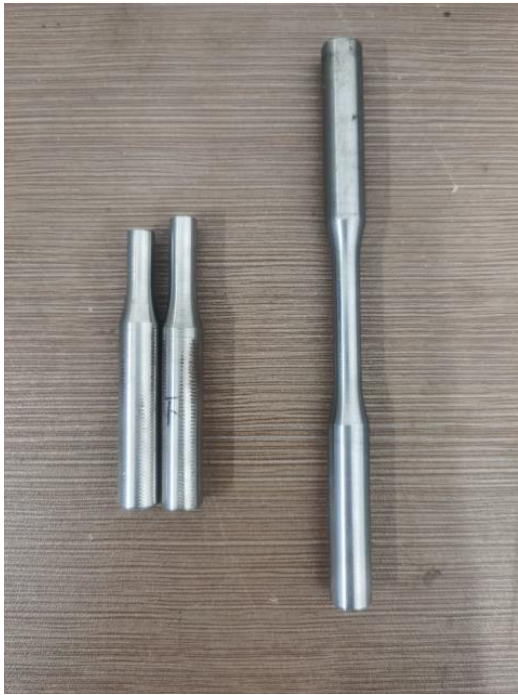
Figure 5. Sample rod for fatigue test.